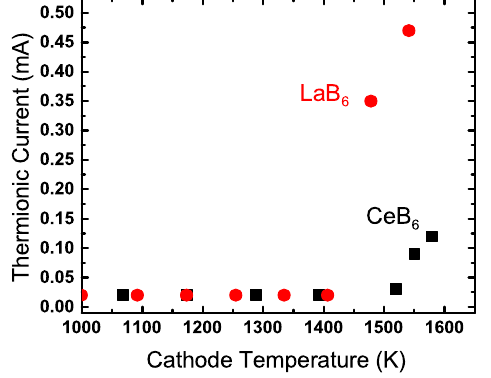
FIG. 4. Thermionic emission from LaB 6 and CeB 6 .